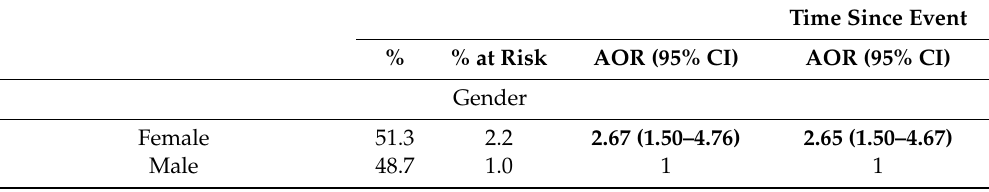
Table 3. The association between sociodemographic characteristics, event type and being at risk for PTSD with and without correction for time since event (adjusted odds ratios and 95% confidence intervals from logistic regression analysis with all variables in the model, N = 4545).